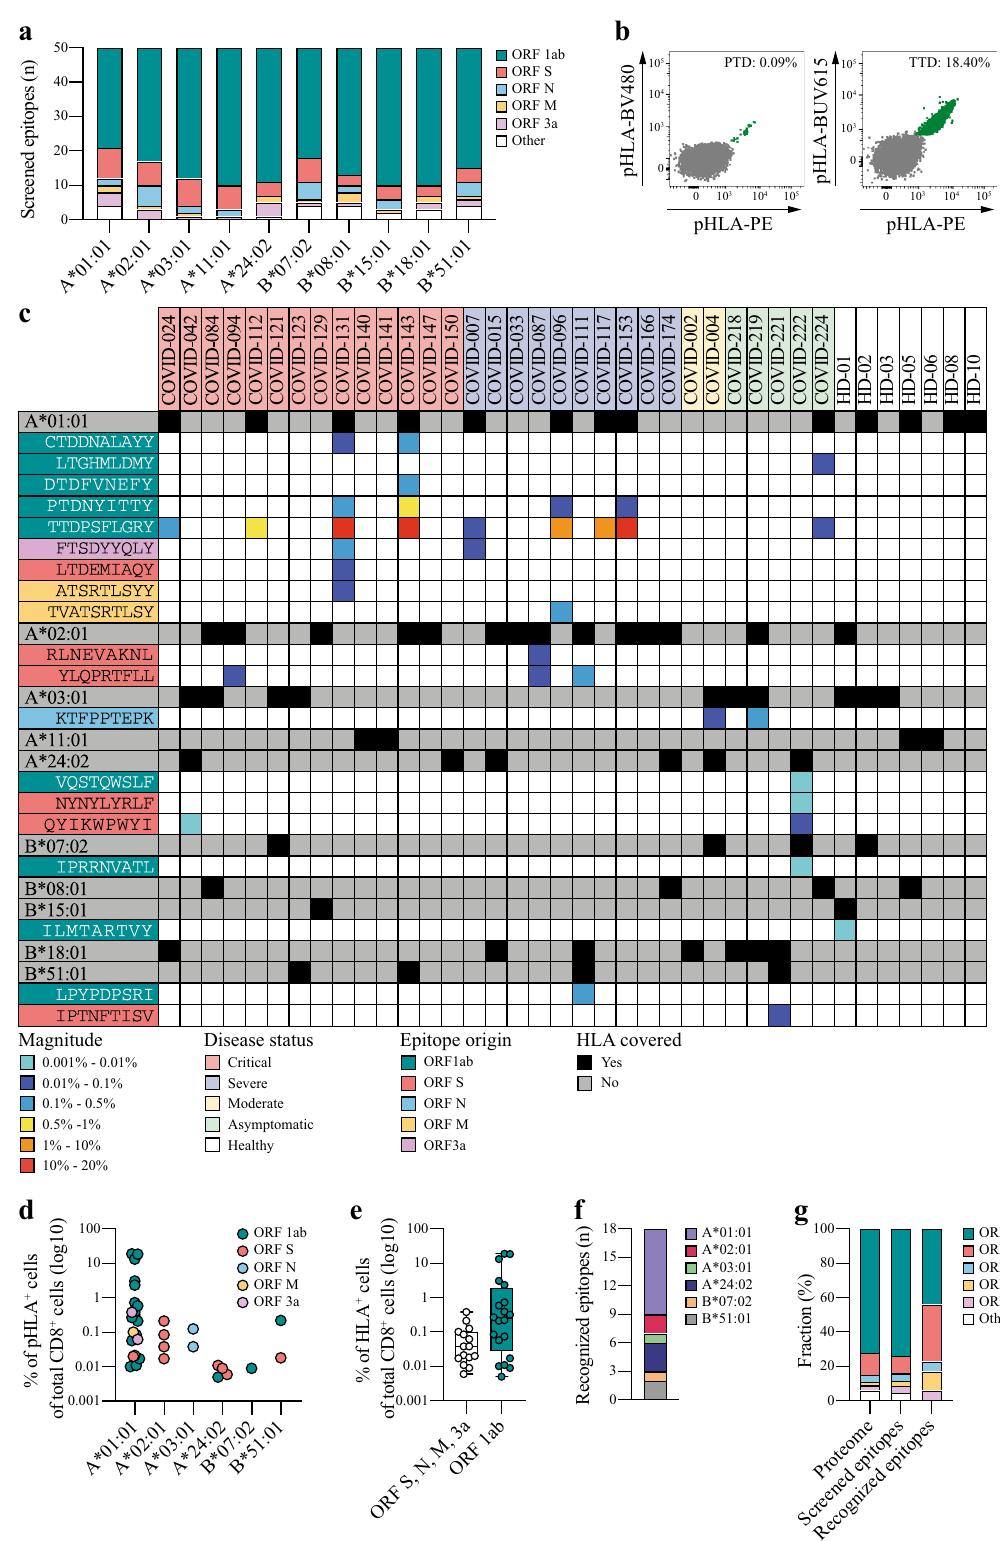
exclude background mutations and possible sequencing artifacts) were reported for only 1 (IPTNFTISV) of the 17 epitopes. Interestingly, this hotspot mutation is one of the de fi ning muta- tions of the recently identi fi ed SARS-CoV-2 B117 variant (T716I: IPINFTISV, global alternative SNV frequency 8.44%; https://www. cogconsortium.uk). It is unlikely that the low impact of the T716I